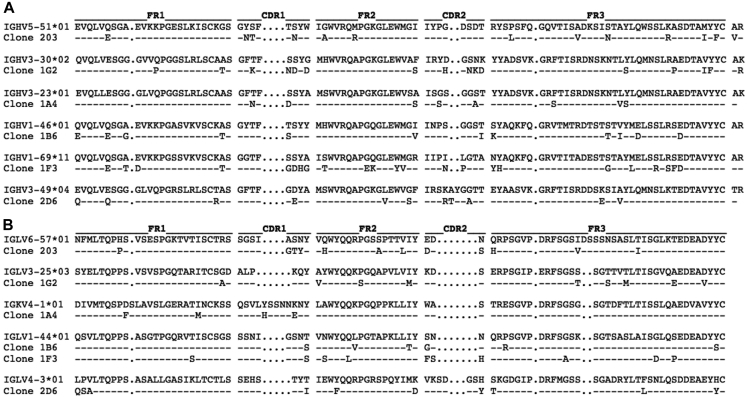
Amino acid sequence alignment for 6 cloned SAE-specific antibodies against germline sequences. The V genes encoding the VH (A) and VL (B) of SAE-specific antibodies were identified by using IMGT/V-Quest. Somatic hypermutations that resulted in amino acid changes are indicated.